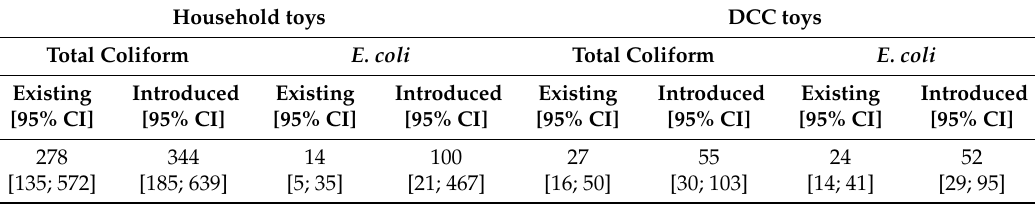
Table 6. Geometric mean (cfu / 100 mL) and 95% CI for total coliform and E. coli data from toys